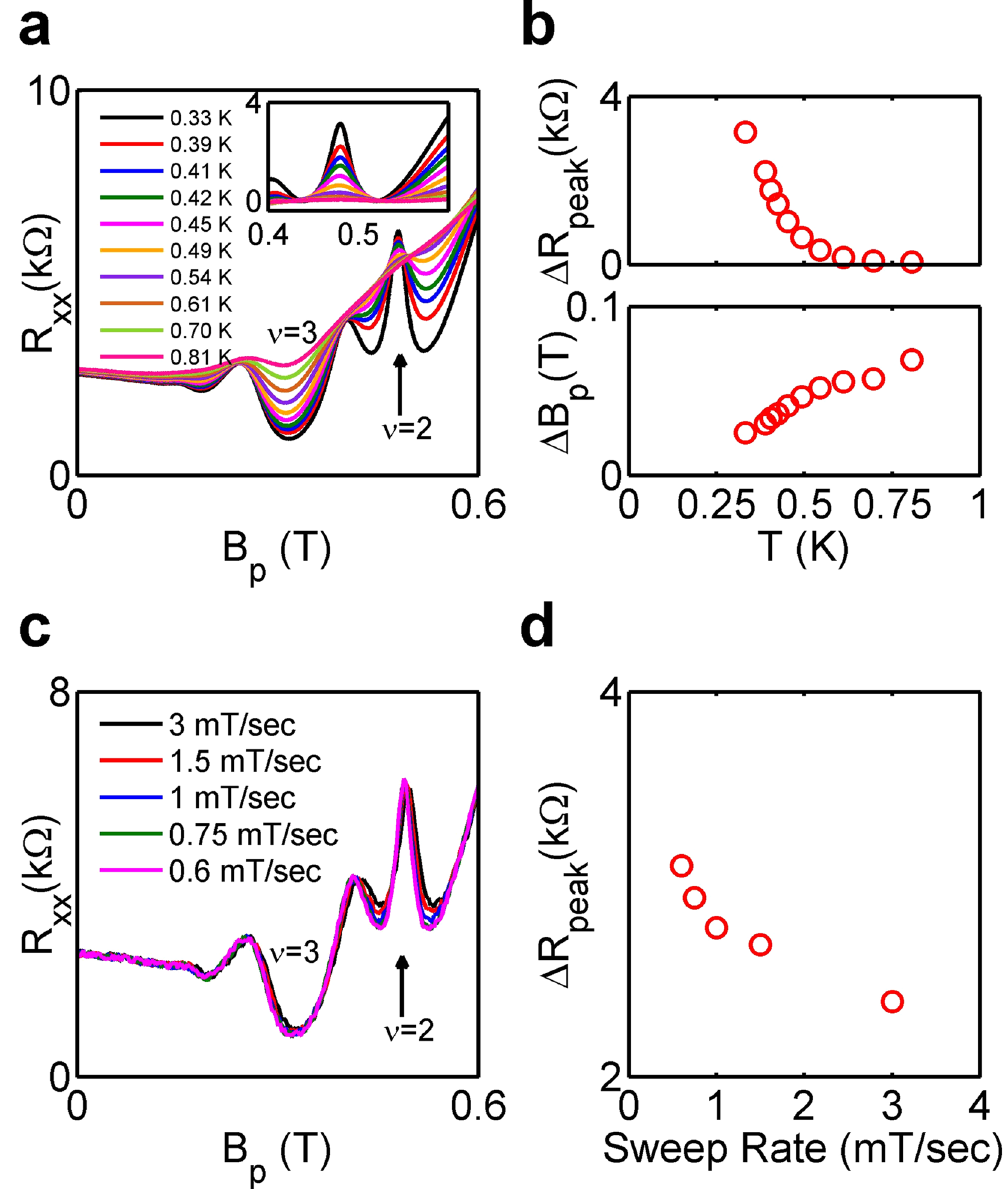
Figure 3. ( a ) Temperature dependence of R xx at p ~ 2.4 × 10 10 cm − 2 . The inset shows the peak with a linear background subtracted from R xx at each temperature. ( b ) Amplitude and width of the resistance peak as functions of temperature are shown in the top and bottom pannels, respectively. Errors are smaller than the size of the symbols. ( c ) Magnetic-field sweep rate dependence of R xx at p ~ 2.4 × 10 10 cm − 2 . ( d ) The peak height as a function of the sweep rate. Errors are smaller than the size of the